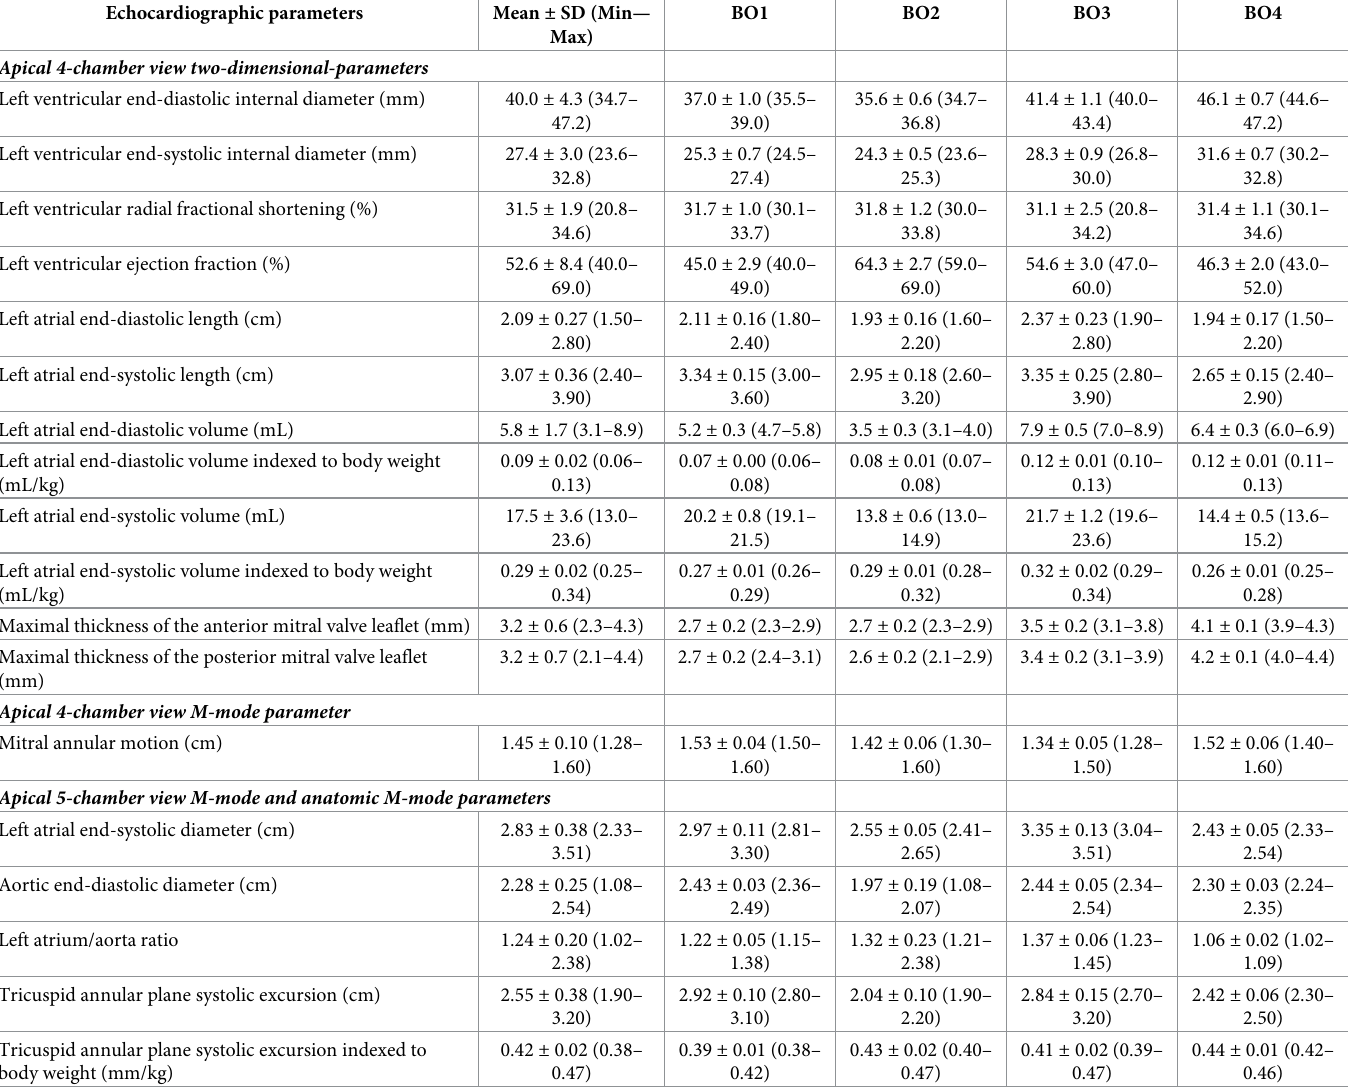
Table 1. Mean ± standard deviation (SD), minimum (Min) and maximum (Max) values of repeated measurements of two-dimensional (n = 12), M-mode (n = 3) and anatomic M-mode (n = 3) echocardiographic variables (n = 18) obtained by a trained observer in 4 Borneo orangutans ( Pongo pygmaeus pygmaeus ) from 96 transthoracic examinations, BO1 to BO3 being the females and BO4 the